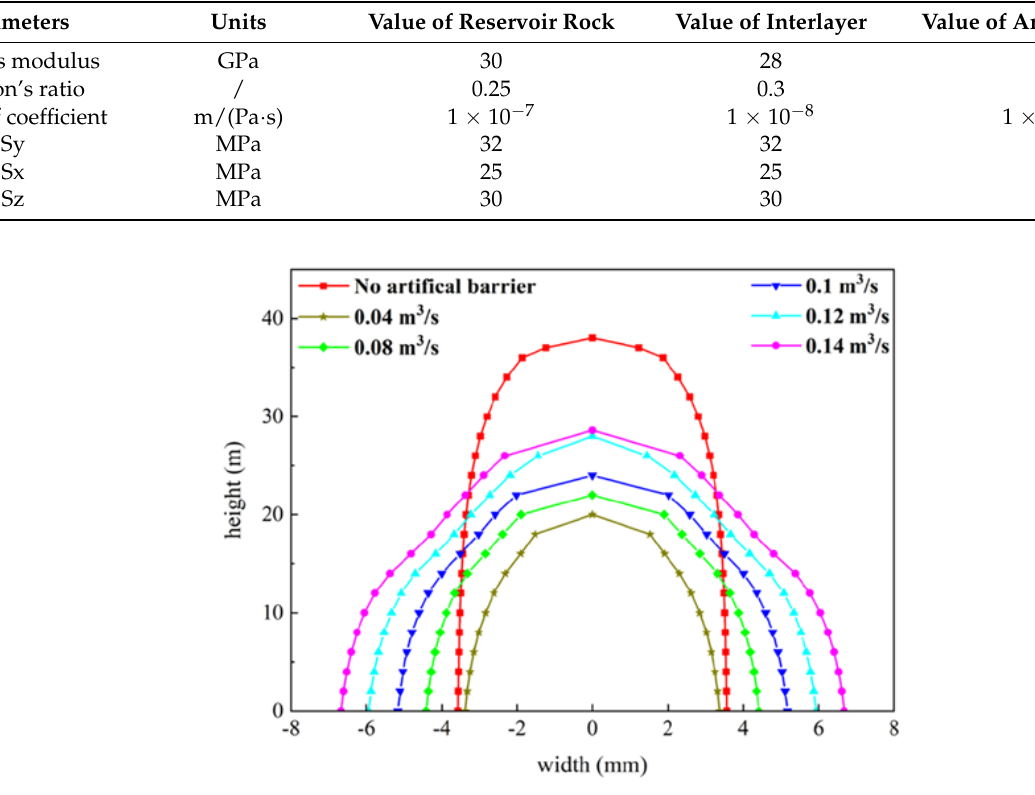
Figure 15. Pore pressure distribution cloud after fracturing under different pumping rate: ( a ) 0.04 m 3 /s, ( b ) 0.08 m 3 /s, ( c ) 0.1 m 3 /s, ( d ) 0.12 m 3 /s.